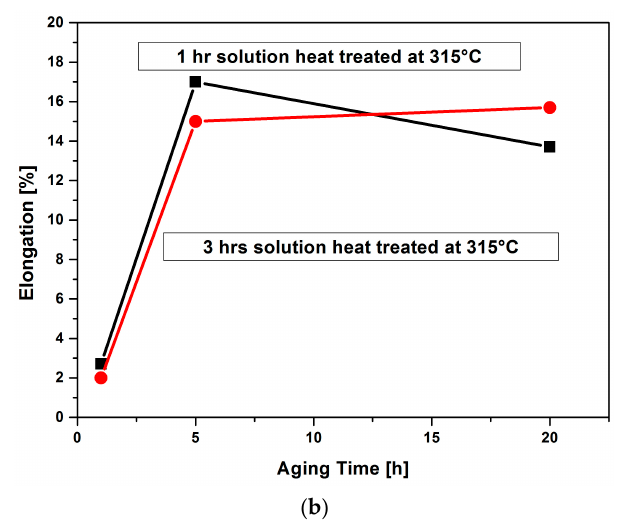
Figure 6. Effects of aging time on a) UTS and b) elongation to fracture of alloy II4 (after [21]).